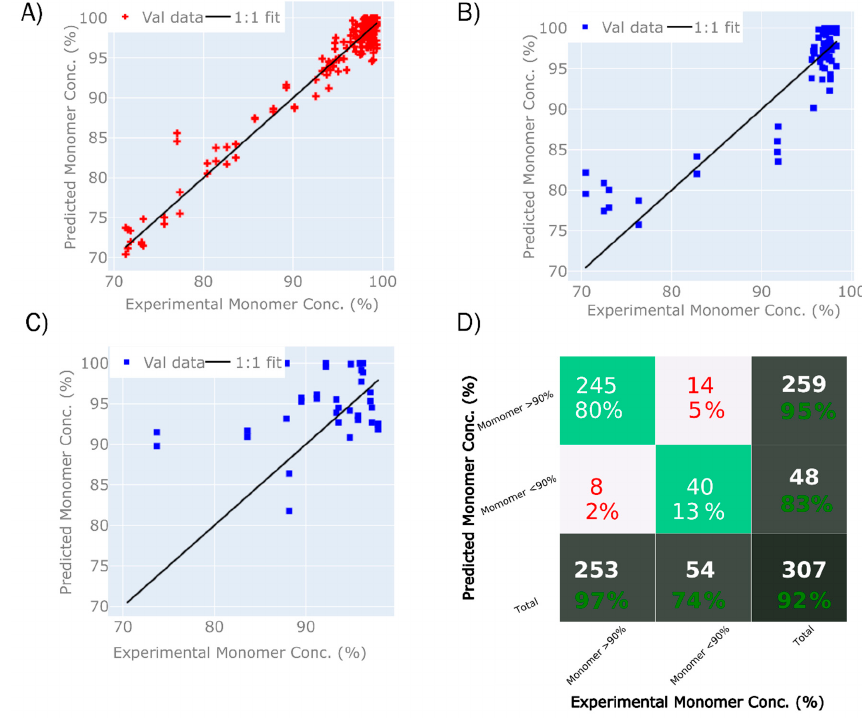
Figure 7. Prediction performance of the PLS model predicting the monomer purity of the fusion protein with ( A ) displaying a parity plot for validation set T1, ( B ) parity plot for calibration set P1, ( C ) parity plot for calibration set P2, and ( D ) confusion matrix that classifies the monomer purity predictions above or below 90% in comparison to the experimental monomer purity. In the confusion matrix ( D ), the top left cell indicates true positives, the top middle cell indicates false positives, the middle left cell indicates false negatives, and the middle cell indicates true negatives. In each of these matrix cells, the value indicates the number and percentage of samples in each category. In the total matrix cell columns and rows, the total number of samples is given, with the percentage indicating the number of true positives or true negatives.